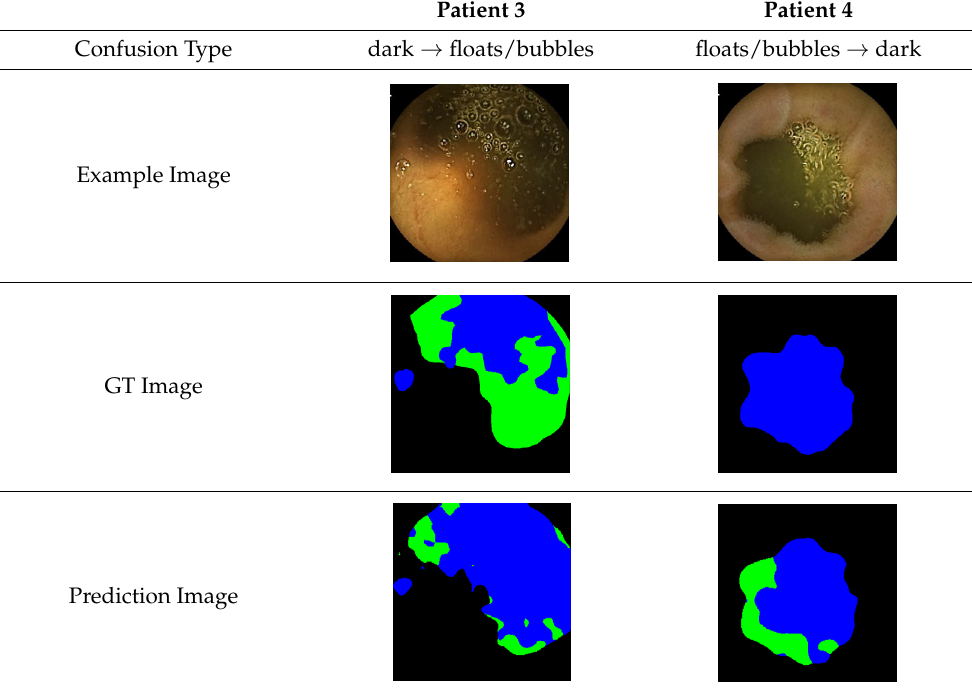
Table 5. Failure cases for Patient 3 and Patient 4 for the 3-class case. Confusion type (first row). Center-cropped images (second row). GT region annotated images (third row). Our prediction results (bottom row).